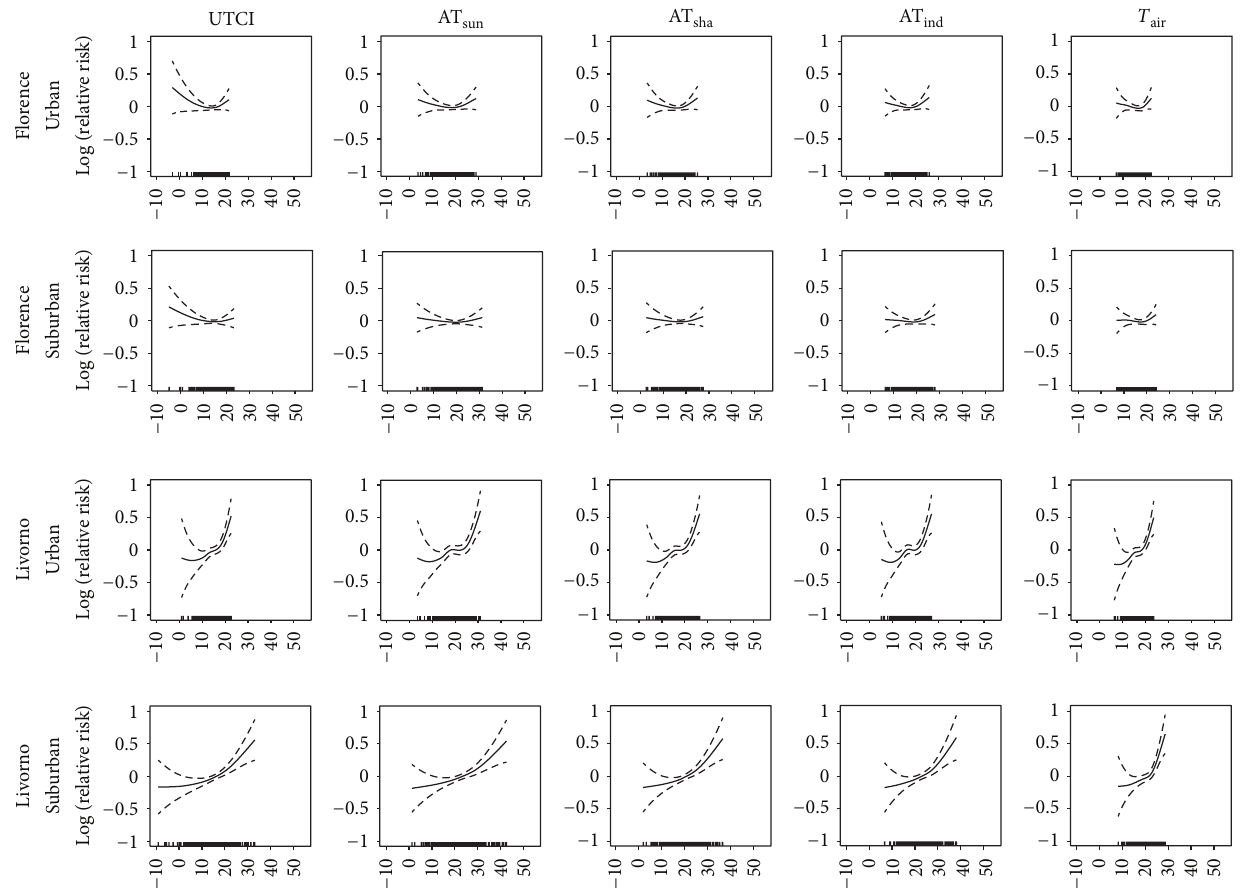
) ( ∘ C) and mortality of the very elderly (subjects ≥ 75 years of age) Figure 3: Relationships between daily minimum thermal predictors ( lag 0 - 1 in an inland city (Florence) and coastal-plain city (Livorno). Relationships estimated by using urban and suburban meteorological data for the period 2006–2008 (May–October). UTCI: Universal Thermal Climate Index; AT sun : apparent temperature assessed outdoors also taking the solar radiation contribution into account; AT sha : apparent temperature assessed outdoors in the shade; AT ind : apparent temperature assessed : environmental temperature. Analyses were controlled for air pollution concentrations, daylight hours, year, day of in indoor conditions; 𝑇 air the week, public holidays, and summer population